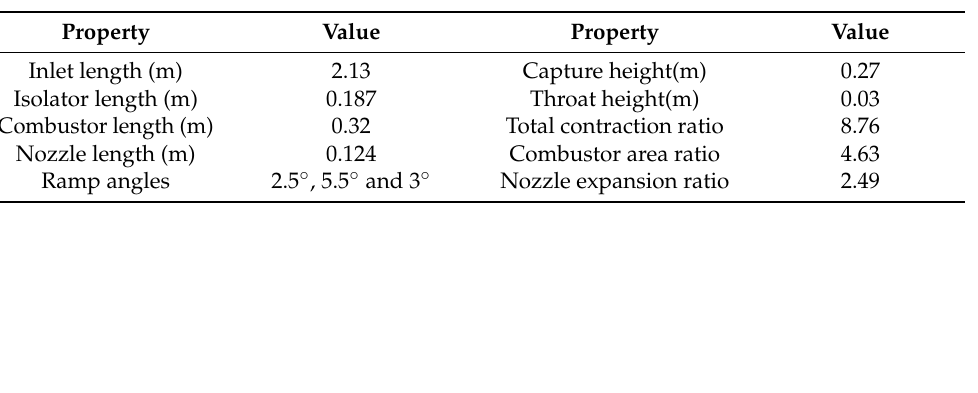
Table 1. Geometric properties of the investigated hypersonic vehicle.